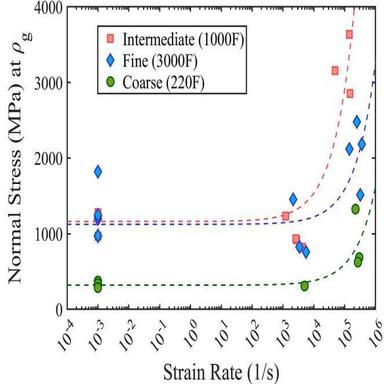
Strain rate effect on granular flow of boron carbide powders. The normal stresses are taken from the stress and density curves at a density ρg of 1700 Kg/m3 . Note that the increment of normal stress with respect to strain rates are larger at ultrahigh rate levels.